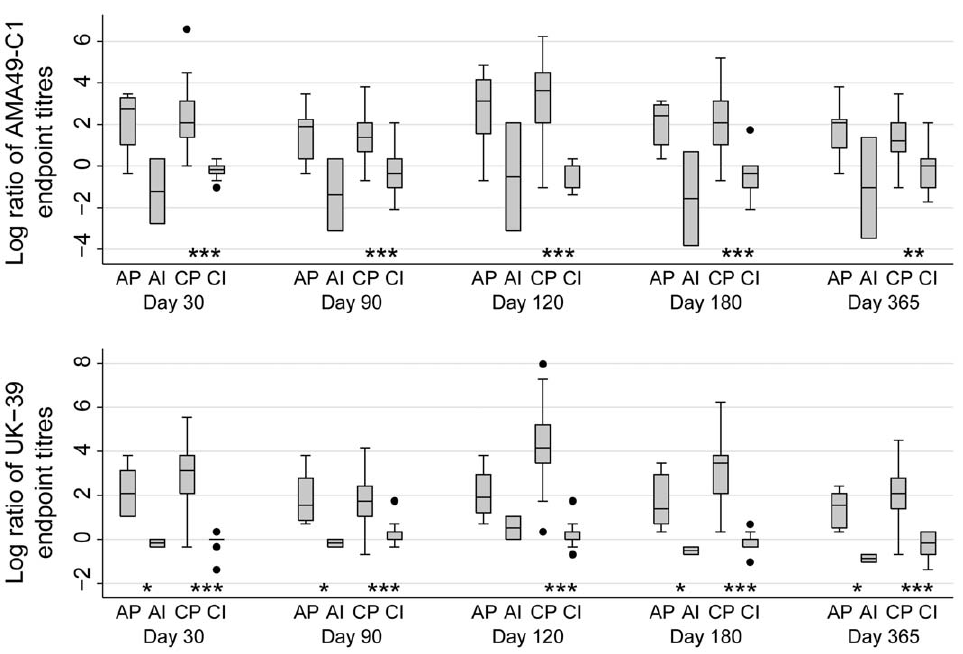
Figure 3. Box-plots of the logarithms of the index of response (ratios of anti-AMA49-C1 and anti-UK-39 IgG ELISA endpoint to baseline titers) for samples taken at day 30, 90, 120, 180, and 365. AP: adults PEV3B, AI: adults Inflexal H V, CP: children PEV3B, CI: children Inflexal H V. At all time points the logarithm of the index of response of AP and CP groups were significantly . 0 (index of response . 1, p , 0.05). This was never observed for the AI and CI groups. Symbols indicate the level of significance for differences in the index of response between PEV3B and Inflexal H V groups within adults and children subjects (exact Wilcoxon test, *: p , 0.05, **: p , 0.01, ***: p , 0.001). (Figure 5). This difference between the two groups of children was statistically significant for the periods day 0–30 and day 0–120 (Figure 5), indicating that UK-39-binding antibodies contribute to prevention of malaria infection. During the study periods from day 0–120 and day 0–365, integrated antibody response for AMA49-C1